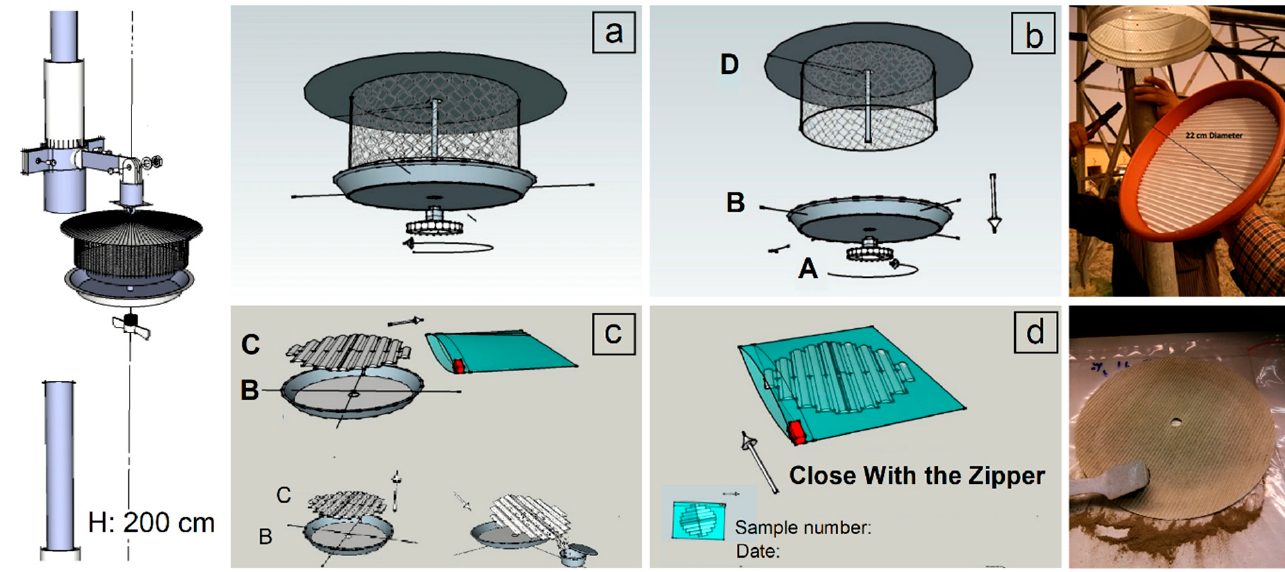
Figure 2. Construction and collection of samples from sampling stations. Sampling process is represented in ( a – d ) respectively. Sampling begins by removing the sample plate [A and B] followed by replacing the filter, and packing samples with caution [C and D] according to [48].